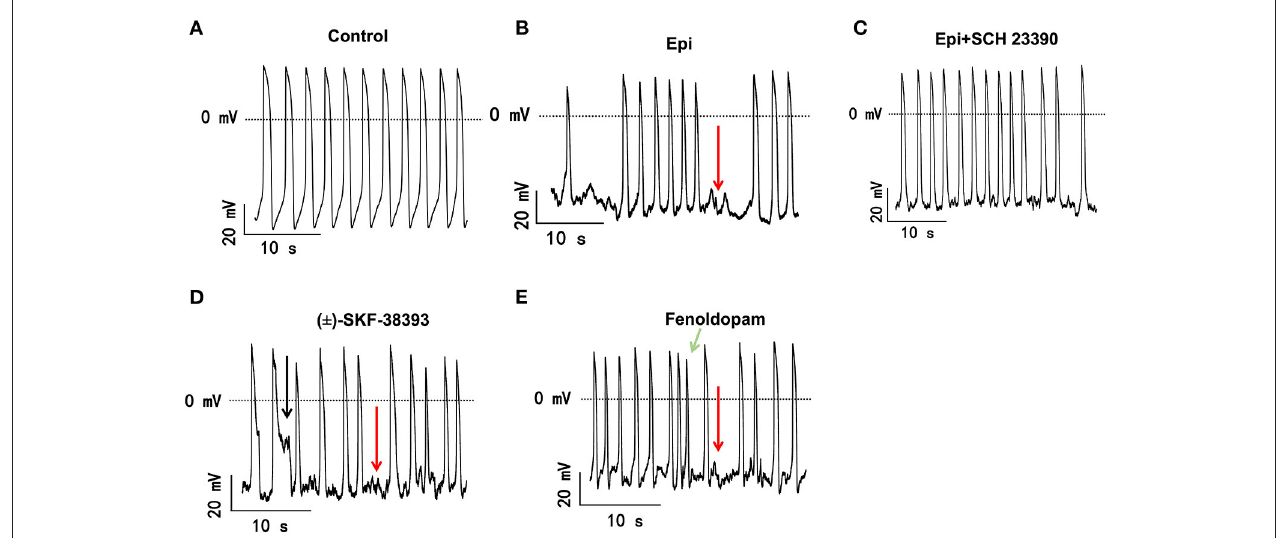
FIGURE 1 | The dopamine D1/D5 receptor activation contributes to occurrence of arrhythmic events. hiPSC-CMs were treated by vehicle (Control) or 500 µ M Epi or Epi plus 10 µ M SCH 23390 or 50 µ M ( ± )-SKF 38393 or 5 µ M fenoldopam for 1h. Spontaneous APs of spontaneously beating hiPSC-CMs were measured in the first 100s after the whole cell configuration was obtained. The arrhythmic events including EAD-like (black arrows) or DAD-like and failed AP (red arrows) events or triggered activity (green arrows) in each cell were counted and divided by total events to obtain the percentage of arrhythmic events. Data were summarized in Table 1 . (A) Representative traces of spontaneous APs recorded in a cell of control group. (B) Representative AP traces in a cell of Epi-group. (C) Representative AP traces in a cell of Epi + SCH 23390 group. (D) Representative AP traces in a cell of ( ± )-SKF 38393 group. (E) Representative AP traces in a cell of fenoldopam